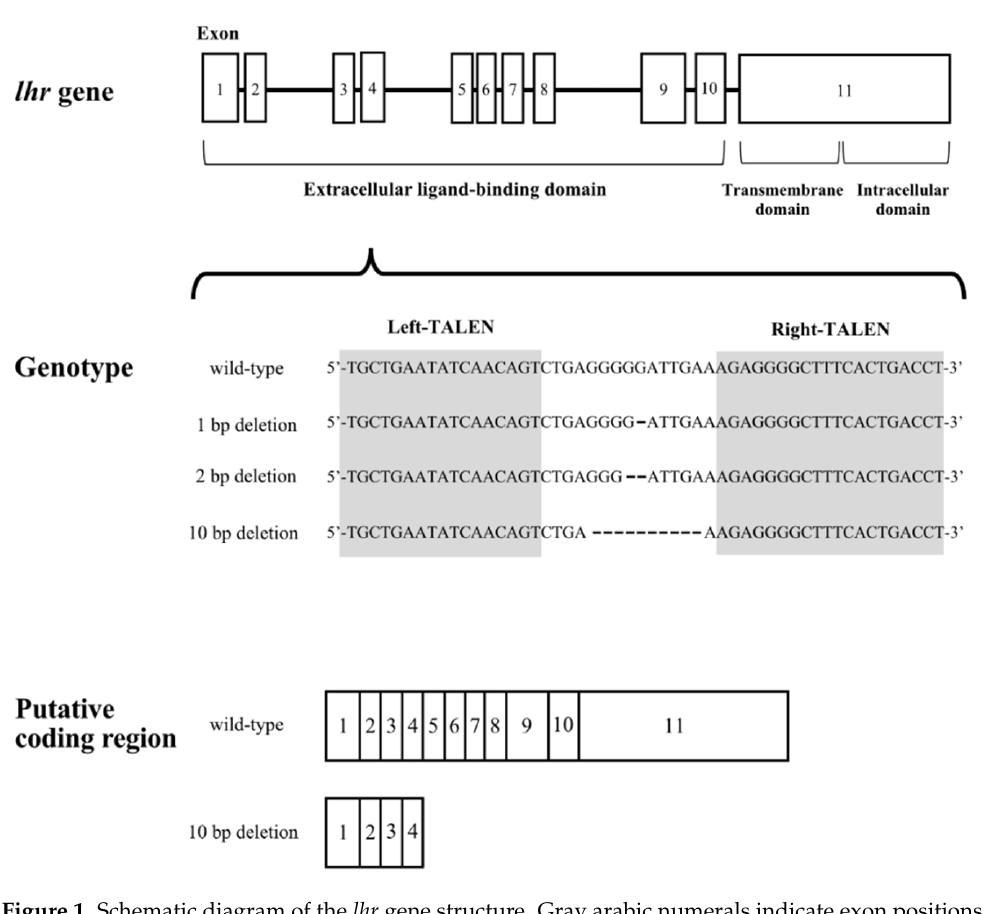
Figure 1. Schematic diagram of the lhr gene structure. Gray arabic numerals indicate exon positions. Shaded sequence indicates the sequence targeted by TALEN in exon 4.